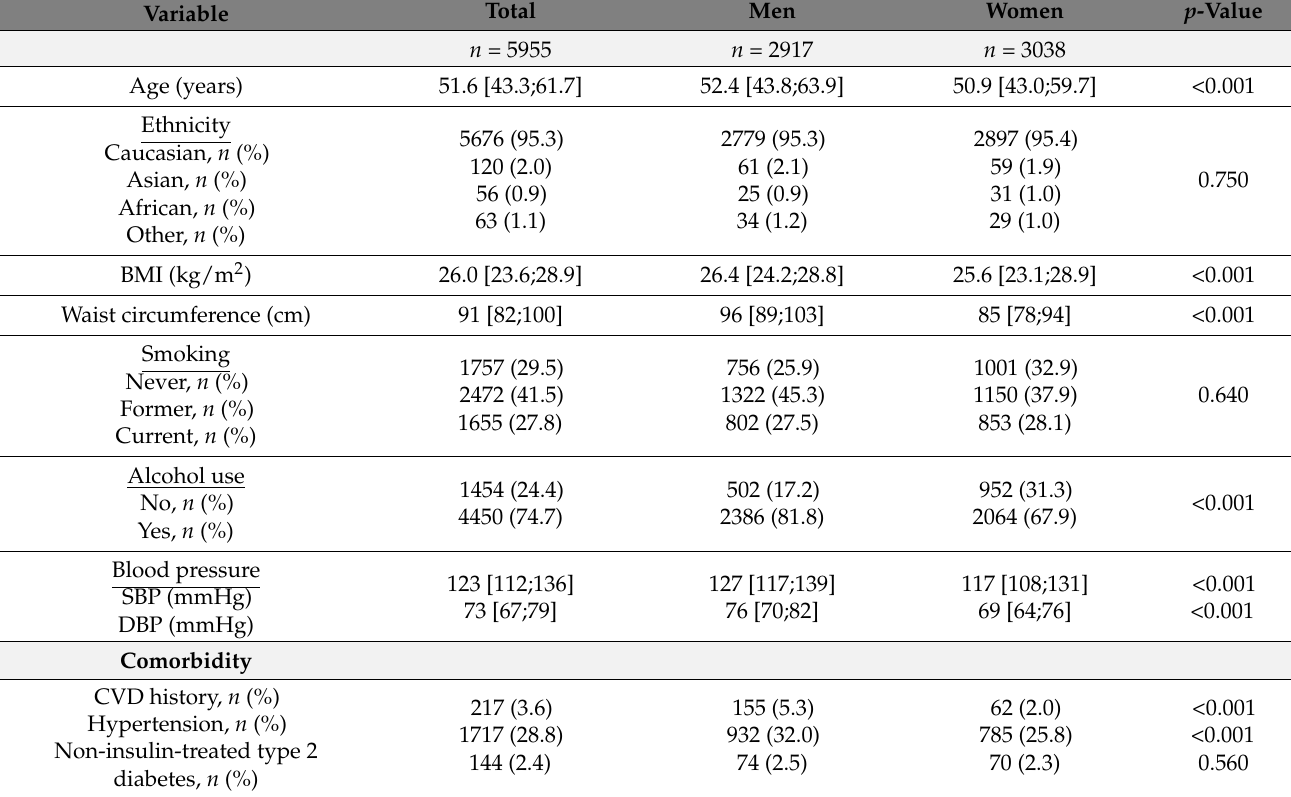
Table 1. Population characteristics and laboratory parameters.